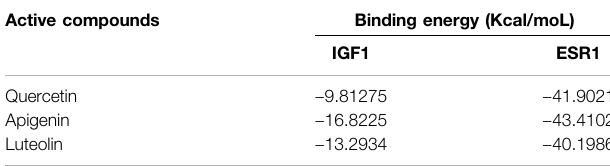
TABLE 5 | Molecular docking results of target and active compounds.